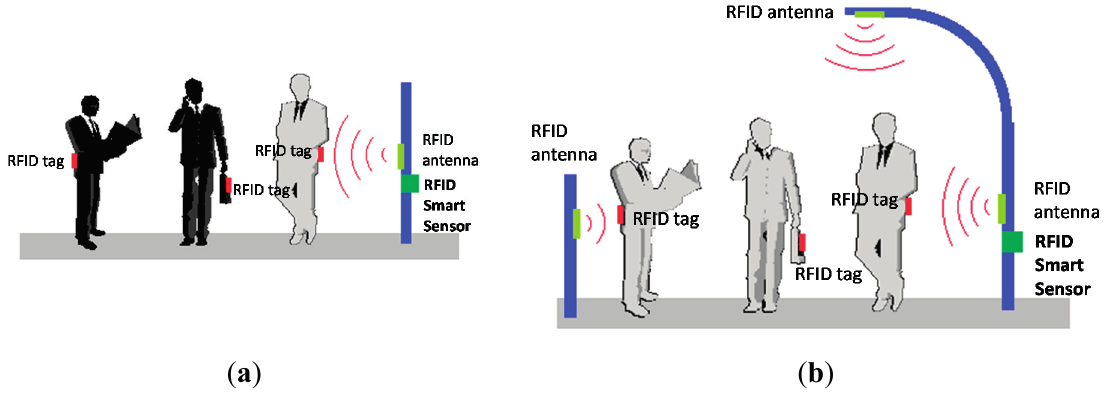
Figure 14. Configuration of the antennas and coverage of RFID sensors: ( a ) One antenna on the right side of a sidewalk; ( b ) Three antennas on the right, left and top of a